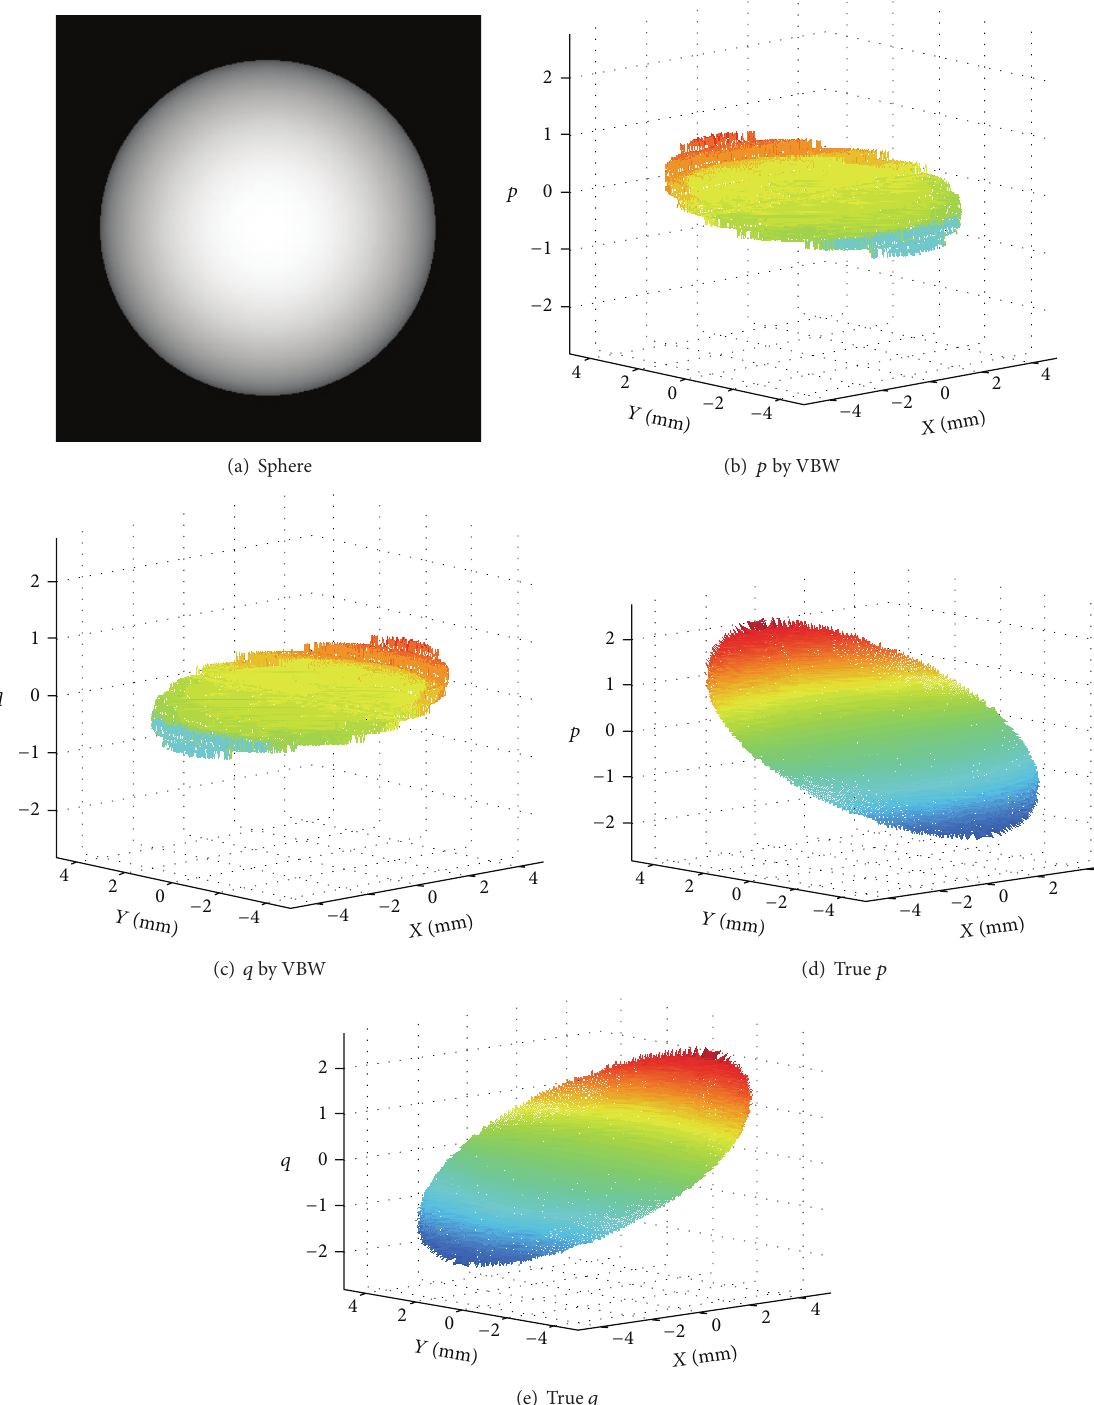
Figure 2: Synthesized sphere for NN